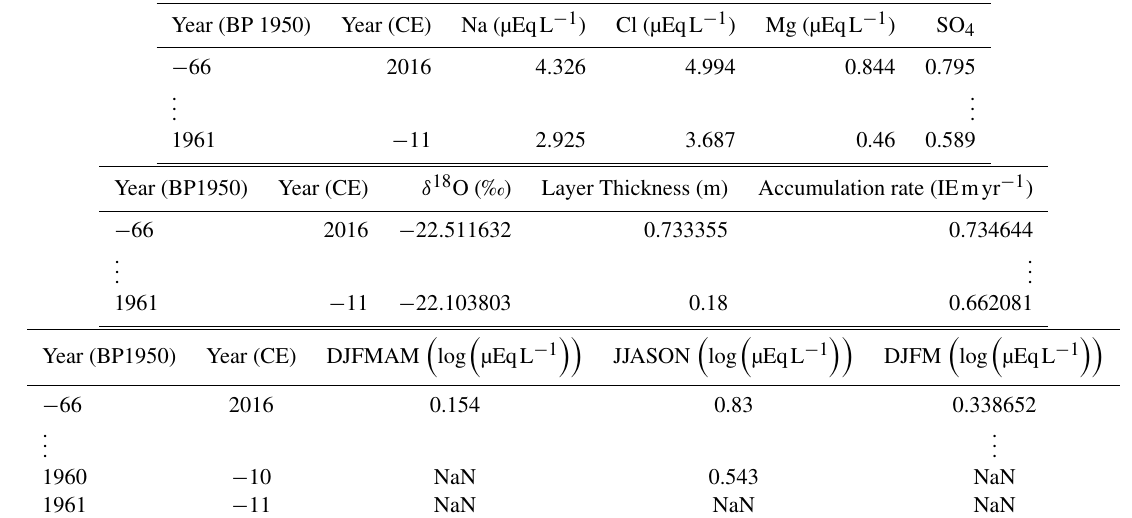
Table 6. Winter-centred annual data columns included in “DSS_2k_winter_centred.csv”